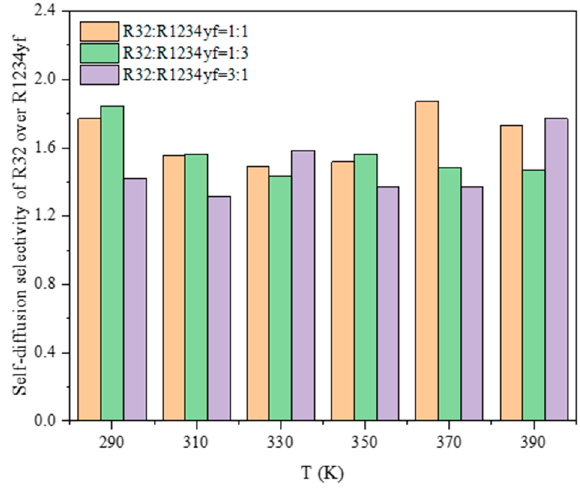
Figure 5. Diffusivity selectivity of R32 over R1234yf in MOF-200.